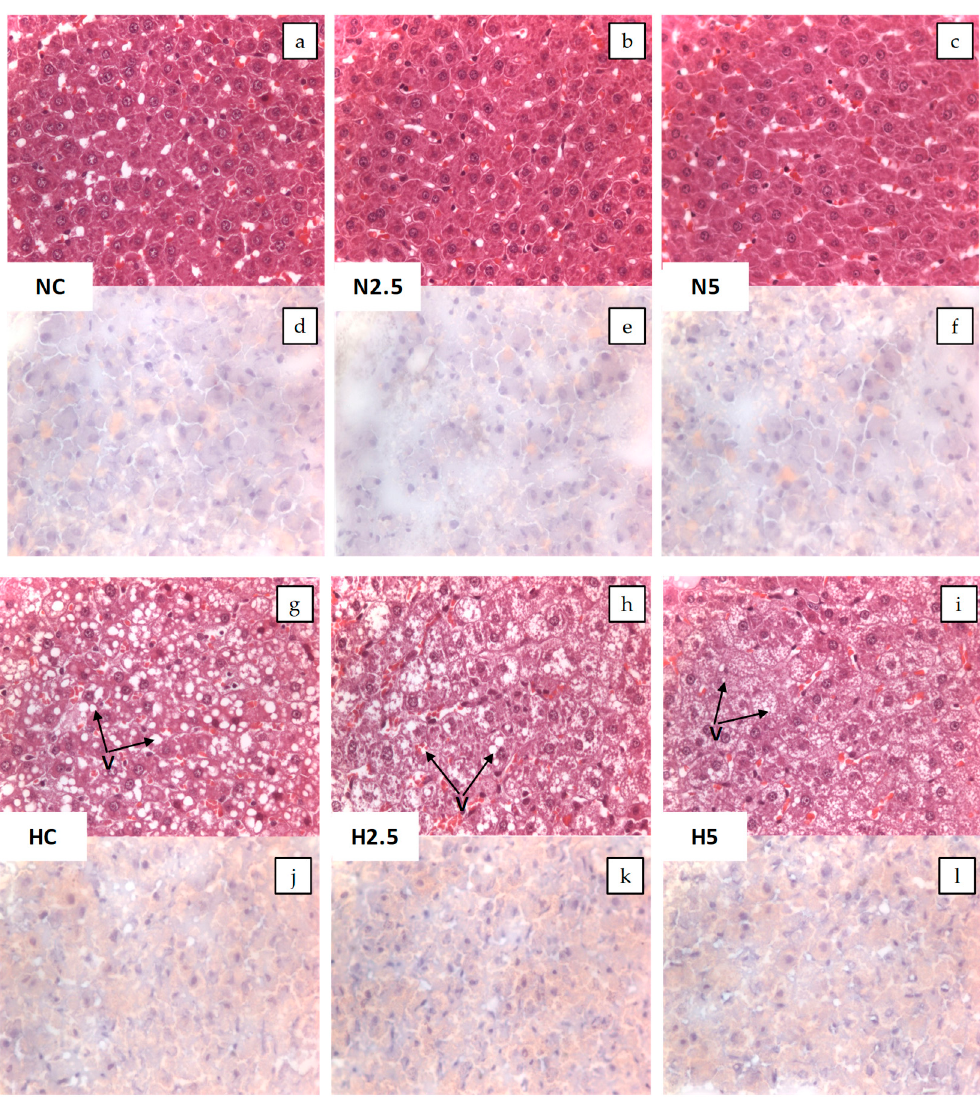
Figure 1. Microscopic photographs of liver tissue. Microscopic images with H&E ( a – c and g – i ) and Sudan III ( d – f and j – l ) visualized by light microscopy (×40) for the control and experimental groups. Arrows show the vacuolar degeneration of the hepatocyte (V). Table 3. Biochemical parameters of plasma, inflammation and oxidative stress biomarkers analyzed in the six experimental groups at the end of the 5-week intervention period 1 .